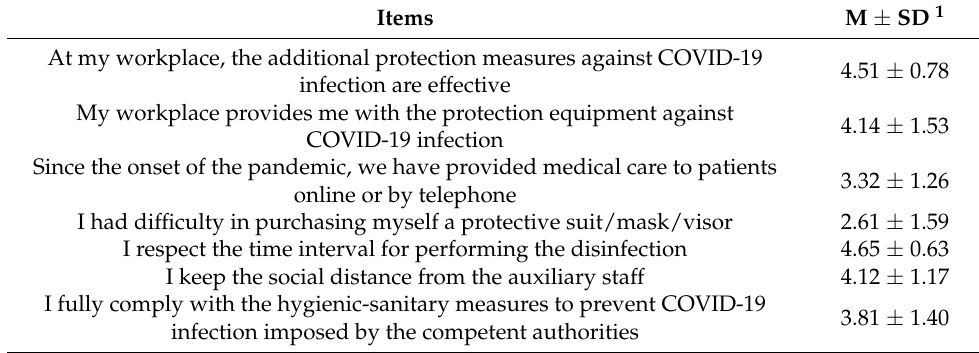
Table 4. Preventive behaviors and institution